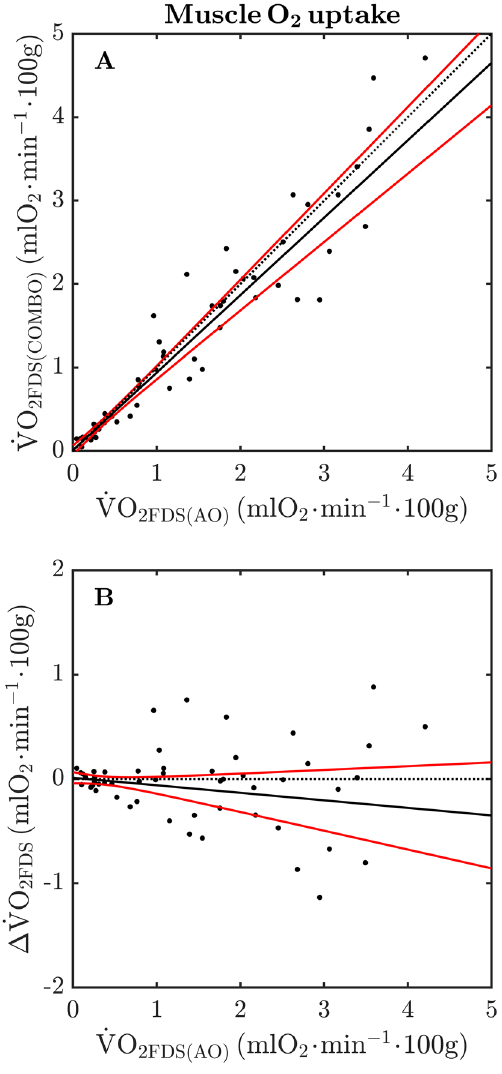
Figure 5. Measurement agreement between arterial and combined occlusion trials for muscle O 2 uptake ( A , B ) of the flexor digitorum muscle (FDS) during isometric handgrip exercise. Solid points represent individual data points from all participants at rest, and immediately following isometric handgrip exercise at 20, 40 and 60% of maximal voluntary contraction. The dotted lines denote the line-of-identity (i.e., perfect agreement). The solid lines represent the predicted group-level response obtained via robust linear mixed effects modeling. The solid red lines represent simultaneous 95% confidence intervals of the predicted group-level response. AO: arterial ˙ VO occlusion; COMBO: combined venous and arterial occlusion; (cid:31) 2 : differences in muscle O 2 uptake AO and COMBO trials, respectively (i.e.,